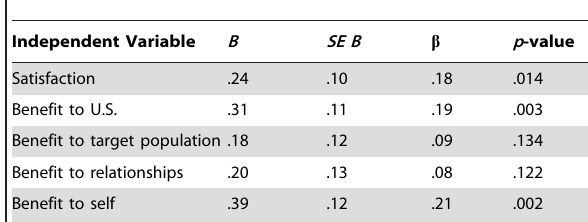
Table 4. Model Summary for the Regression Analysis of Participants’ Intentions to Extend their Military